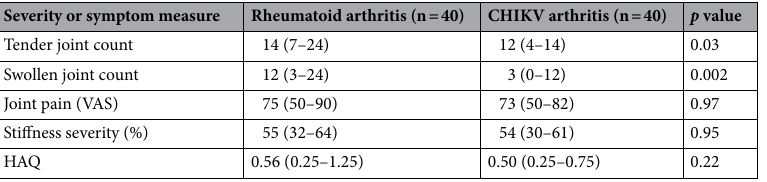
Table 1. Disease characteristics of patients with rheumatoid and chikungunya arthritis. Results expressed as median (interquartile range).